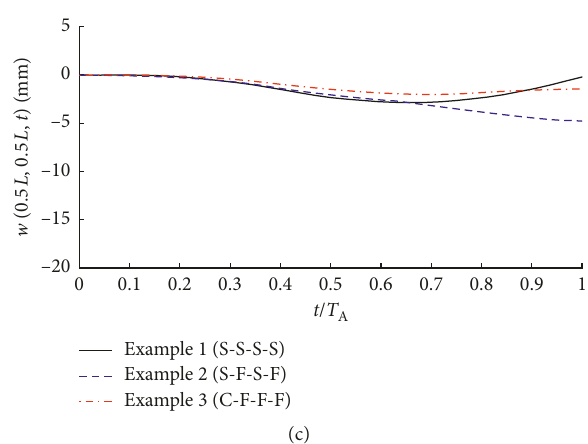
Figure 16: Effects of boundary conditions and moving speed v a moving point force travels along the trajectory given by Case 1 of (39). (a) v 0